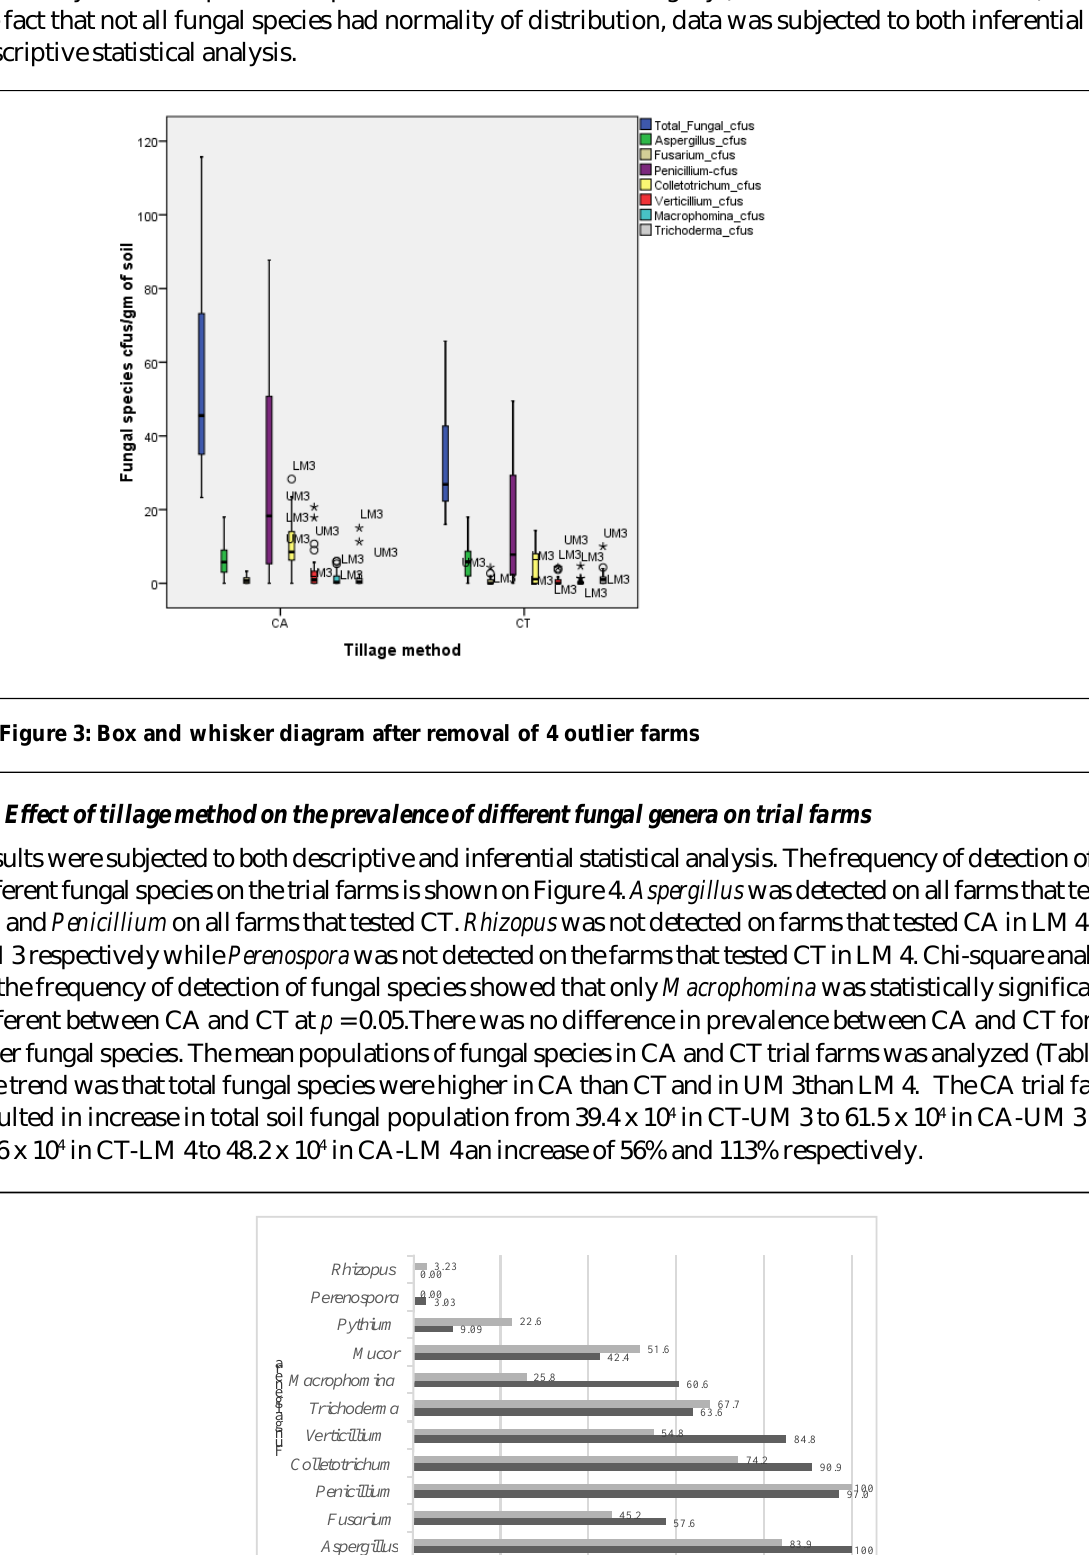
Figure 4: Percent number of farms in which various fungal species were